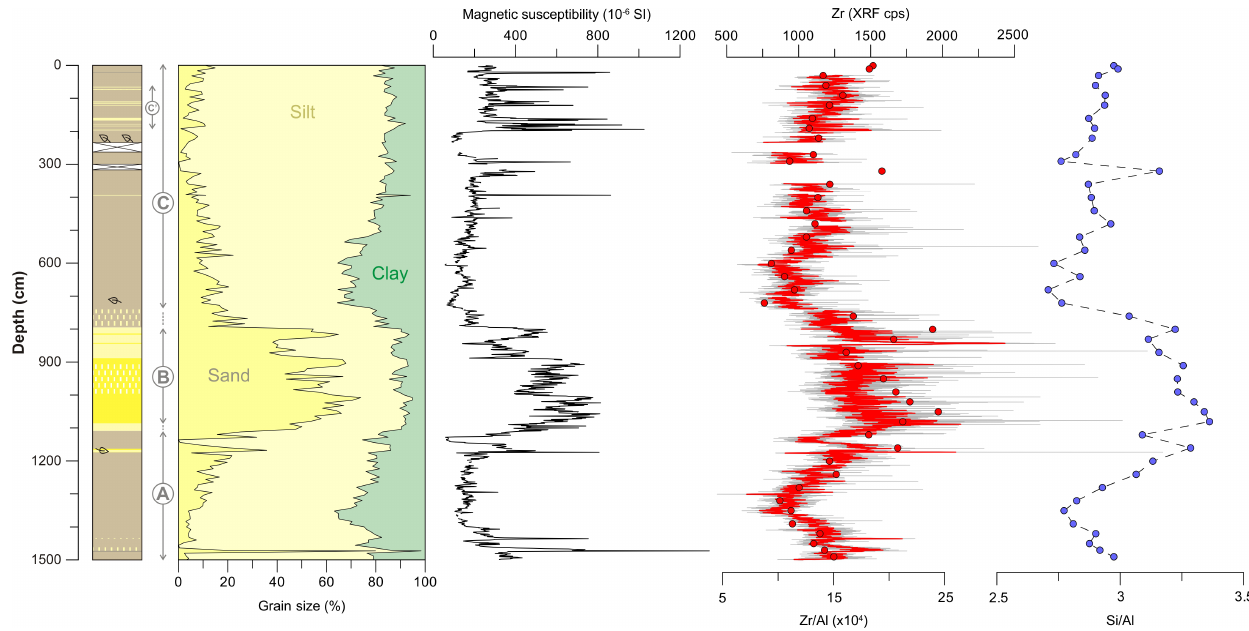
Fig. 3. Selected physical and geochemical proxies in sediment core JPC14 (grain size, magnetic susceptibility, Zr XRF core scanner counts, and Zr/Al and Si/Al elemental ratios).